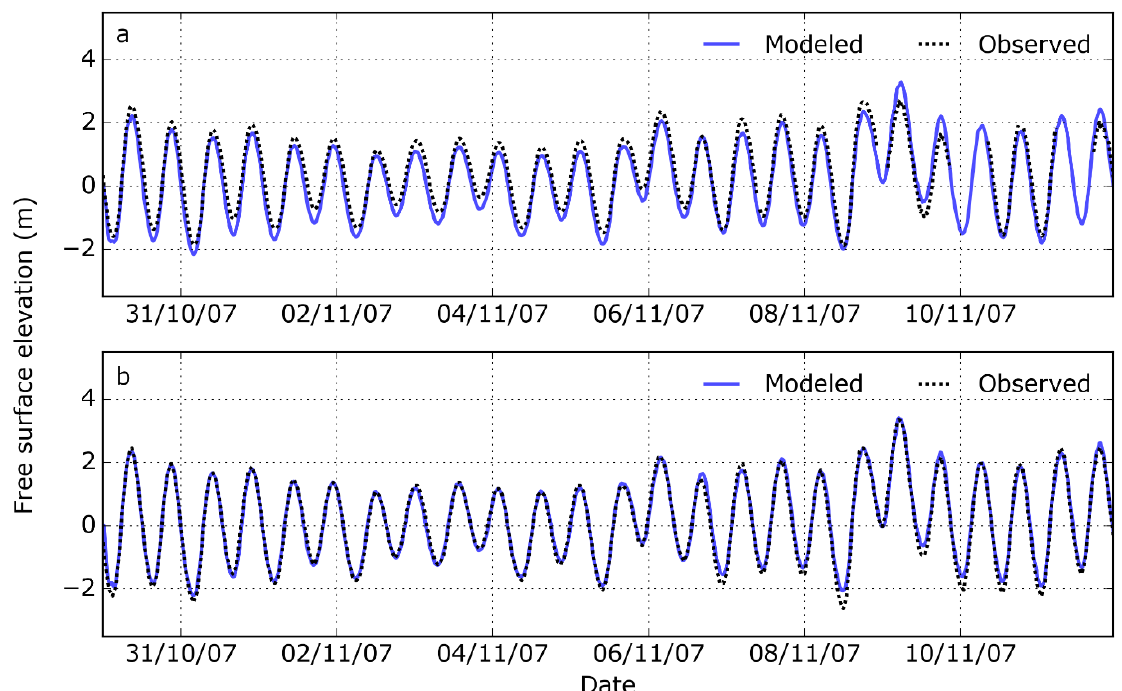
Figure 4. Comparison of modeled and observed water levels for the period 30 October 2007 00:00:00 to 11 November 2007 00:00:00: ( a ) Cromer; ( b ) Cley. RMSE = 0.34 m at Cromer and 0.16 m at Cley. For locations, see Figure 1a,b.